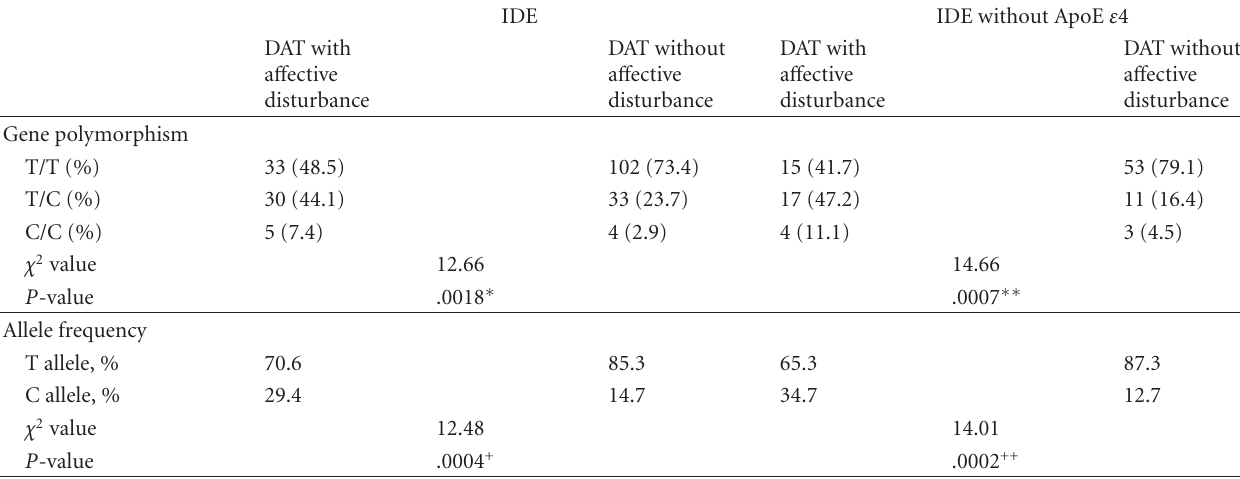
Table 3: Genotype distributions and allele frequencies of IDE gene polymorphism in DAT patients with and without a ff ective disturbance after stratification according to ApoE ε 4 allele.